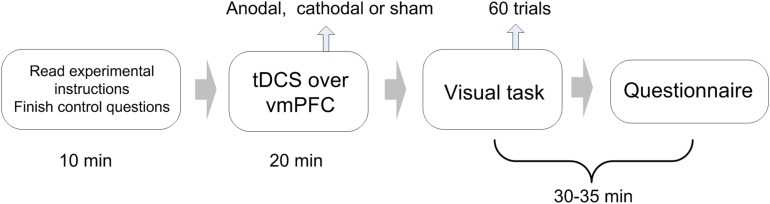
Experimental design.